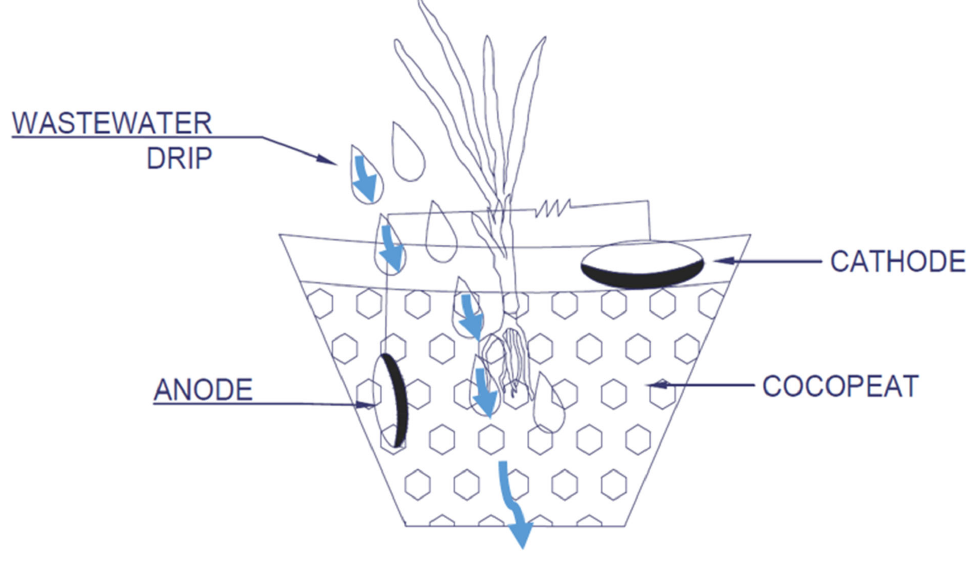
Figure 10. Representation of one of the reactors of the Hyp ‐ MFC system ( adapted from Yadav et al. (2020) [73] ).